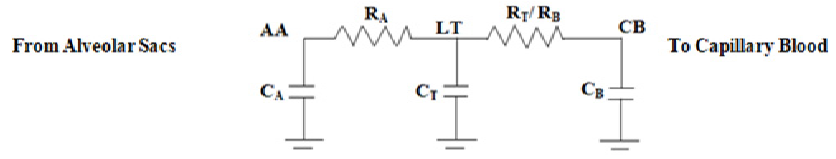
Figure 6. Electrical equivalent circuit diagram of the gas exchange model.